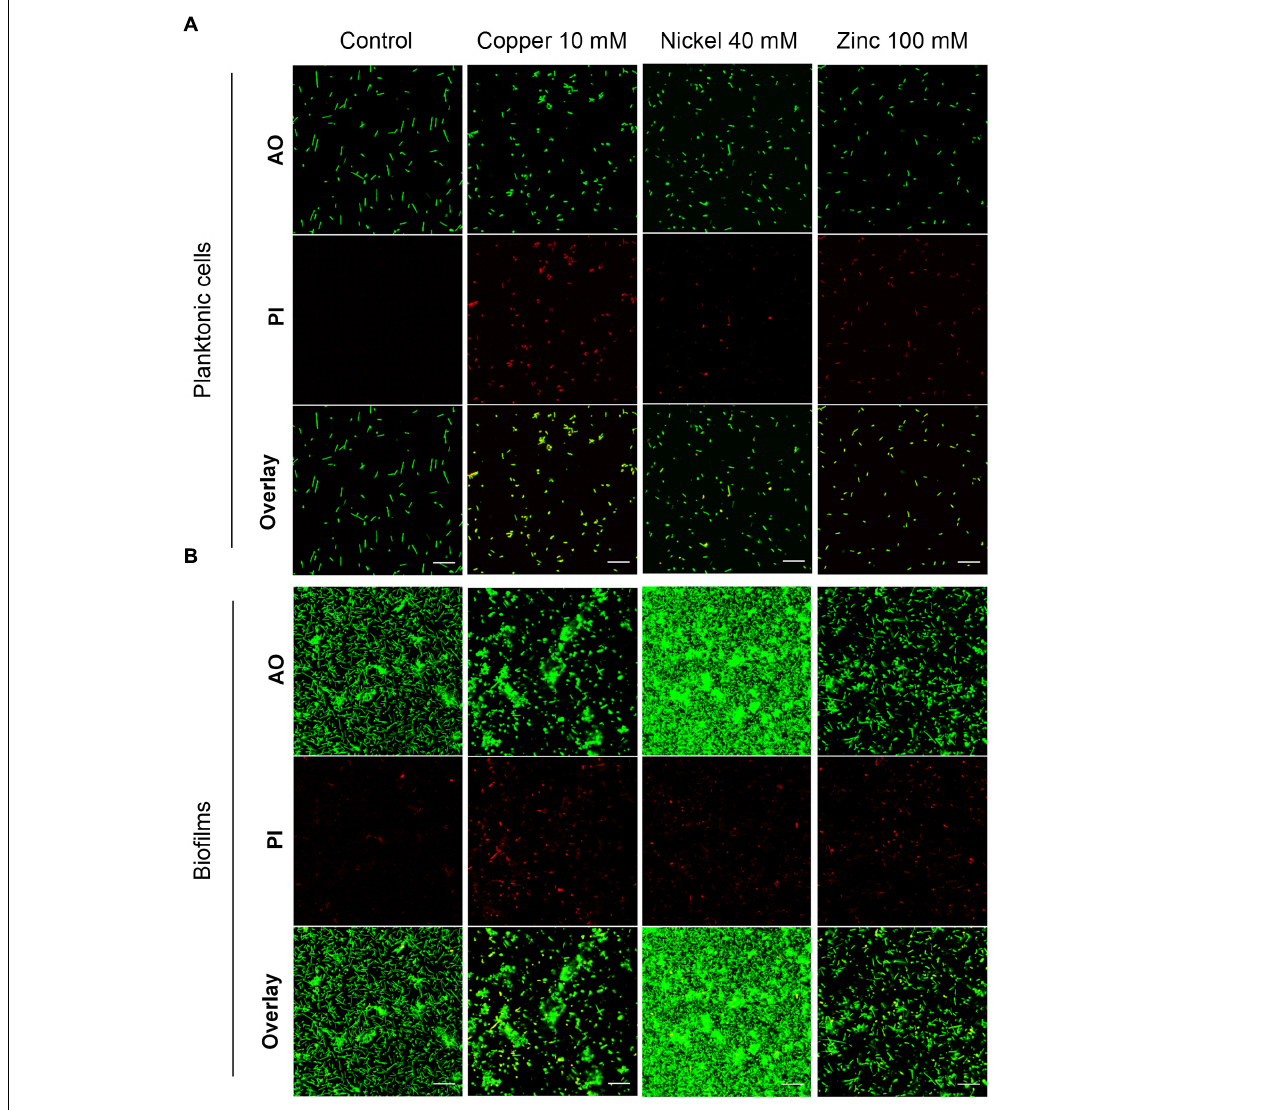
FIGURE 3 | Effect of 24 h exposure to metal ions on H. salinarum planktonic cells and mature biofilms. Before staining planktonic cells (A) were metal treated at OD 600 0.3, biofilms (B) were exposed to metals after 12 days of growth in complex medium. The images show the biofilms at the bottom of the wells. Live/dead staining was done using acridine orange (AO) to stain intra- and extracellular nucleic acids, and propidium iodide (PI) staining eDNA and dead cells. Scale bars equal 20 µ m in each